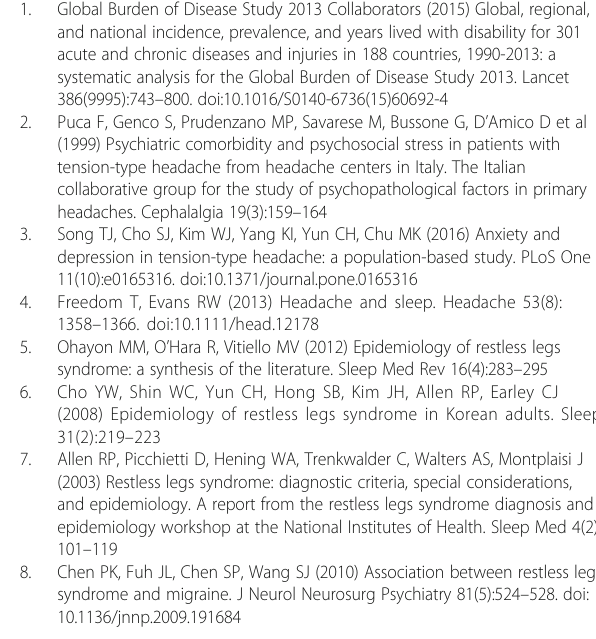
Additional file 1: Table S1. Sociodemographic characteristics of survey participants, the total Korean population, and cases identified as having TTH and RLS. (DOCX 20 kb)